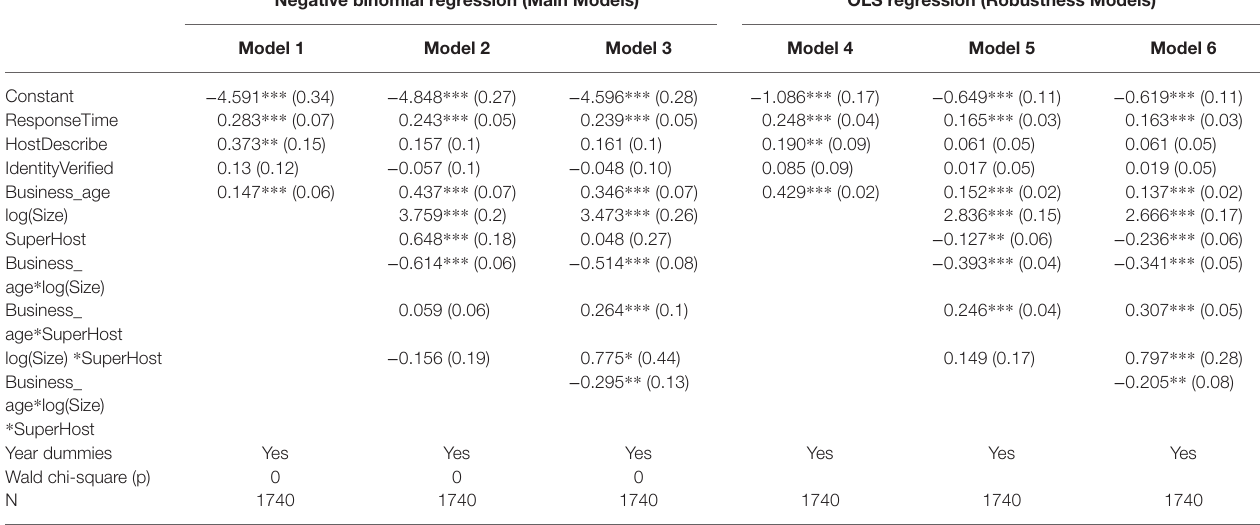
TABLE 3 | Regression result. Negative binomial regression (Main Models) OLS regression (Robustness Models)